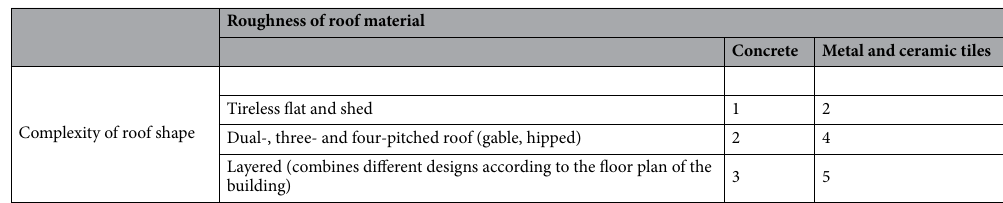
Table 3. Potential leaf accumulation on the roof.